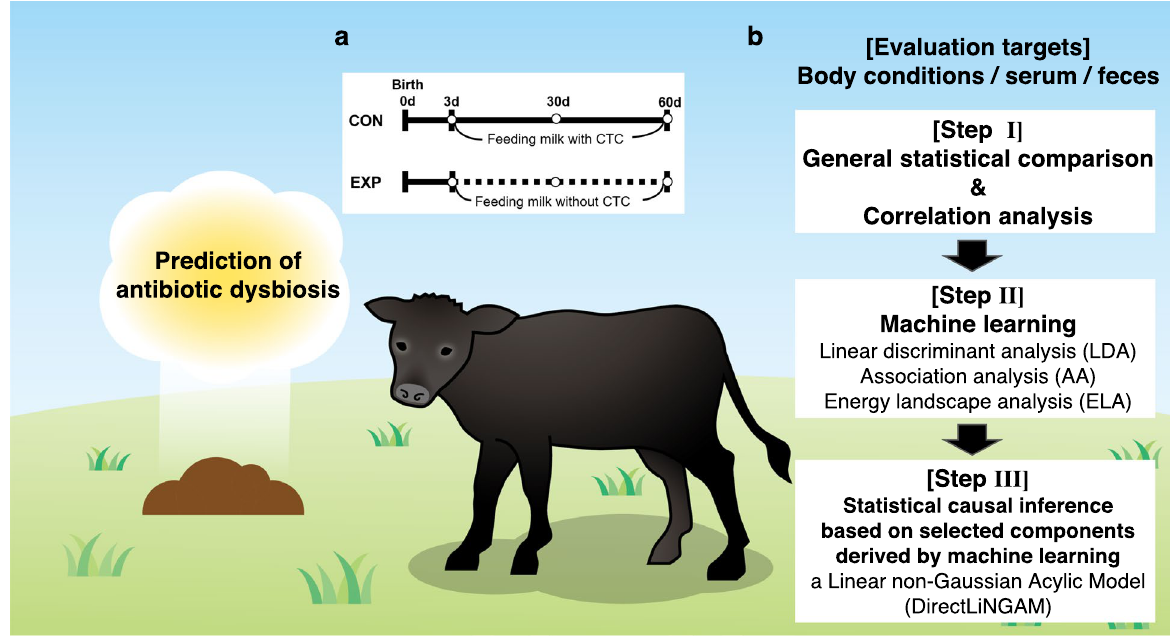
Figure 1. Experimental design, experimental procedure, and research objectives. ( a ) Illustration of the experimental design. In the early postnatal period [from day ( d ) 3 to d 60], when the rumen had not yet developed, the antibiotic treatment group (CON) and the nontreatment group (EXP) were established. ( b ) The analysis target and its procedure are shown. In Step I, general statistical comparisons and correlation analyses were performed; in Step II, to screen for potential relationships among factors, supervised linear discriminant analysis (LDA), unsupervised association analysis (AA), and energy landscape analysis (ELA) were performed as machine learning (ML). In Step III, to statistically determine the causal relationship between the factors narrowed down by ML, linear non-Gaussian acyclic model (DirectLiNGAM) analysis, which can be applied to non-Gaussian distributions, was implemented to statistically estimate the causal relationship between factors refined by ML. These three steps allowed us to infer the mechanism of intestinal disturbance induced by antibiotics (dysbiosis) in